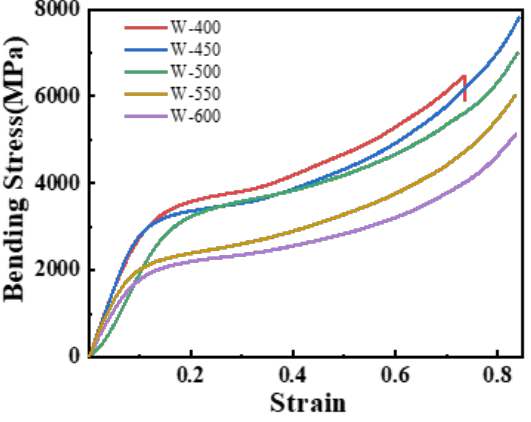
Figure 10. Bending stress–strain curve of multilayer composite steel.